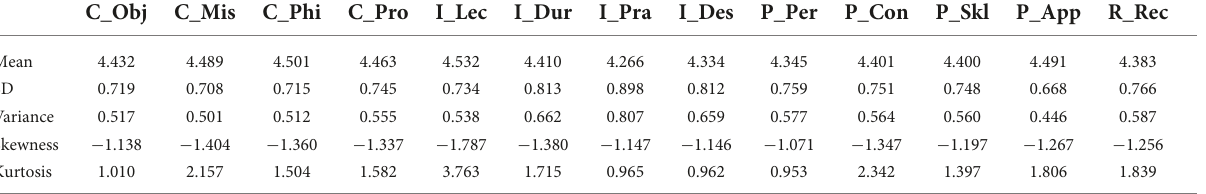
TABLE 4 Summary